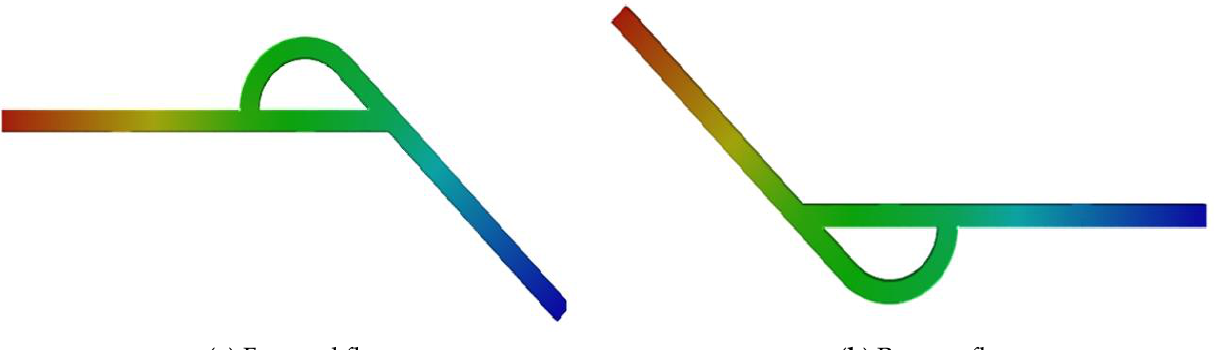
Figure 7. Pressure distribution cloud map.